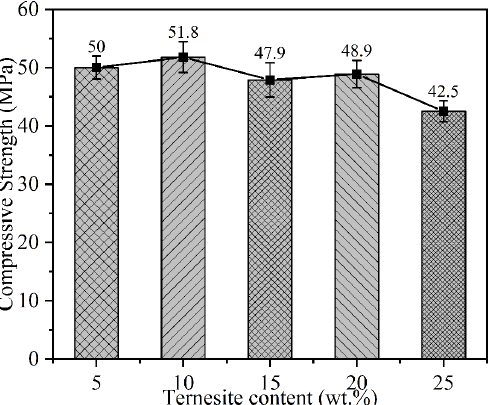
Figure 13. The compressive strength (180 d) of BYT cement relation with the ternesite content in the clinker.